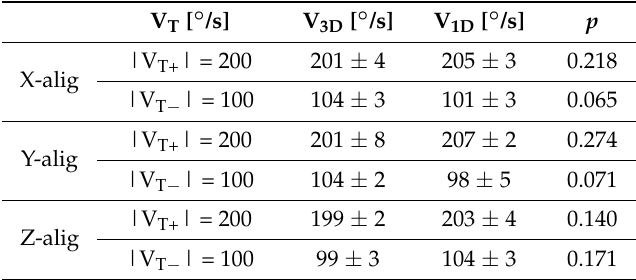
Table 1. Results of t -test analysis used for comparative evaluations between 3D gyro (V 3D ) and 1D gyro (V 1D ) recordings. p value < 0.05 indicates statistically significant differences.